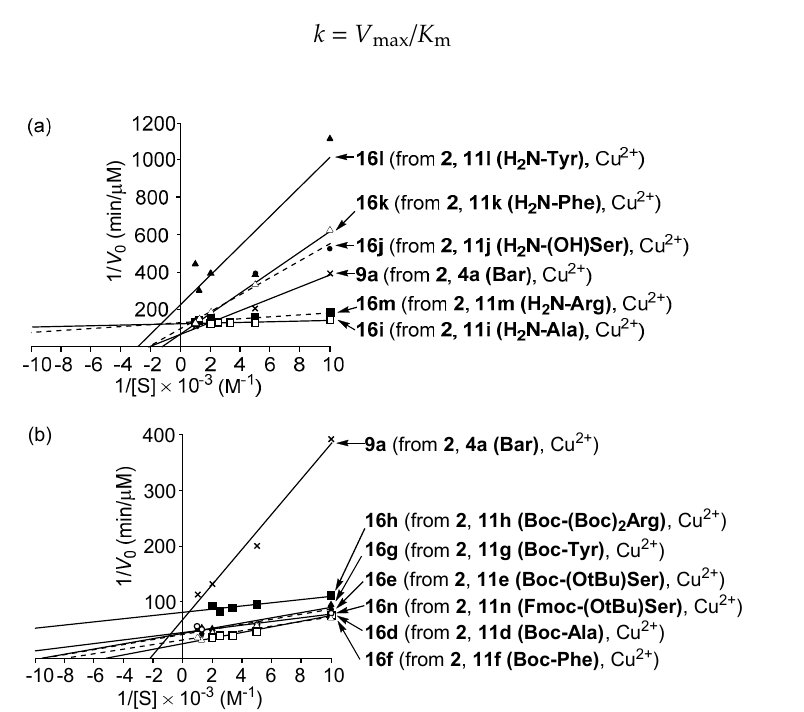
Figure 10. ( a ) Lineweaver–Burk plots for the hydrolysis of MNP catalyzed by 9a (cross with plain line), 16i (open squares with plain line), 16j (closed circles with dashed line), 16k (open triangles with plain line), 16l (closed triangles with plain line), and 16m (closed squares with dashed line). ( b ) Lineweaver–Burk plots for the hydrolysis of MNP by 9a (crosses with plain line), 16d (open squares with plain line), 16e (closed circles with dashed line), 16f (open triangles with dashed line), 16g (closed triangles with plain line), 16h (closed squares with plain line), and 16n (open circles with plain line).